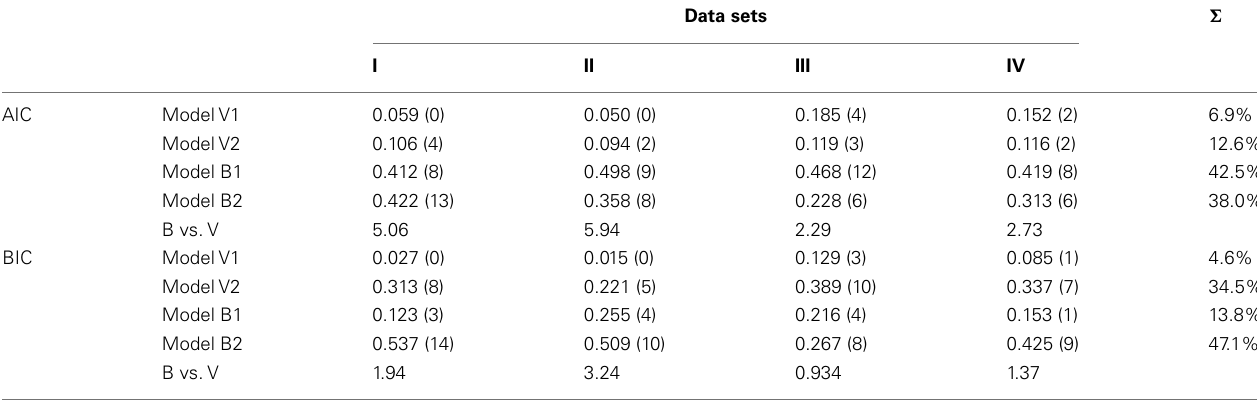
Table 2 |AIC and BIC weights for ModelsV1 andV2 (“drift” models) and B1 and B2 (“threshold” models) for each of the four data